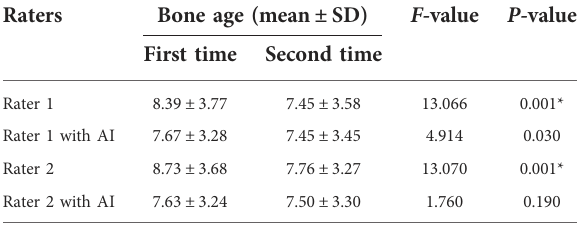
TABLE 3 Intra-rater effects in two times of bone age evaluation with and without AI.